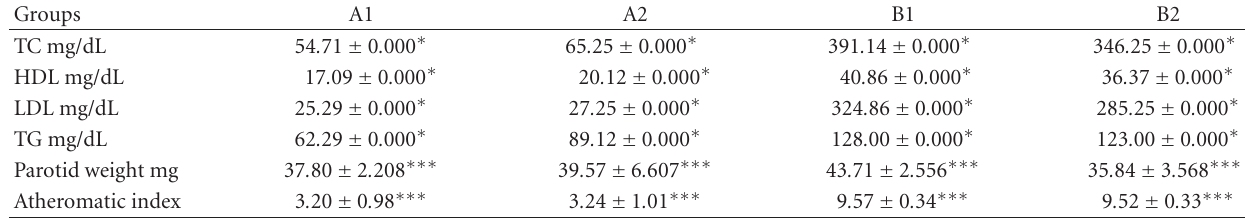
Table 1: Mean and standard deviation of mean of total cholosterol (TC), triglycerides (TG), high density lipoproteins (HDL), low -density lipoproteins (LDL), parotid gland-liver-thymos-spleen-adrenal weight, and atheromatic index in the four groups (A1, A2, B1, B2).